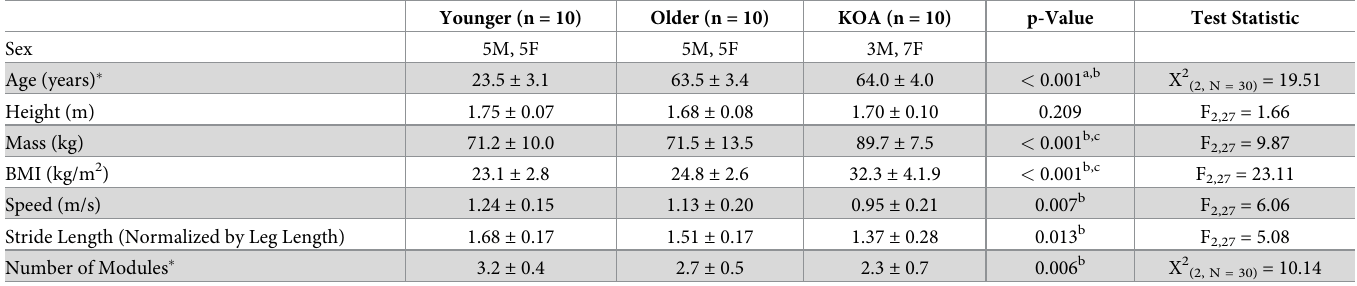
Table 1. Population demographics.